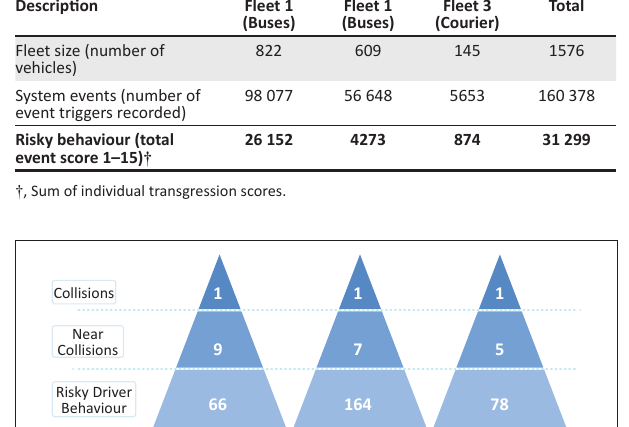
FIGURE 5: Fleet 2 – Average number of incidents per vehicle